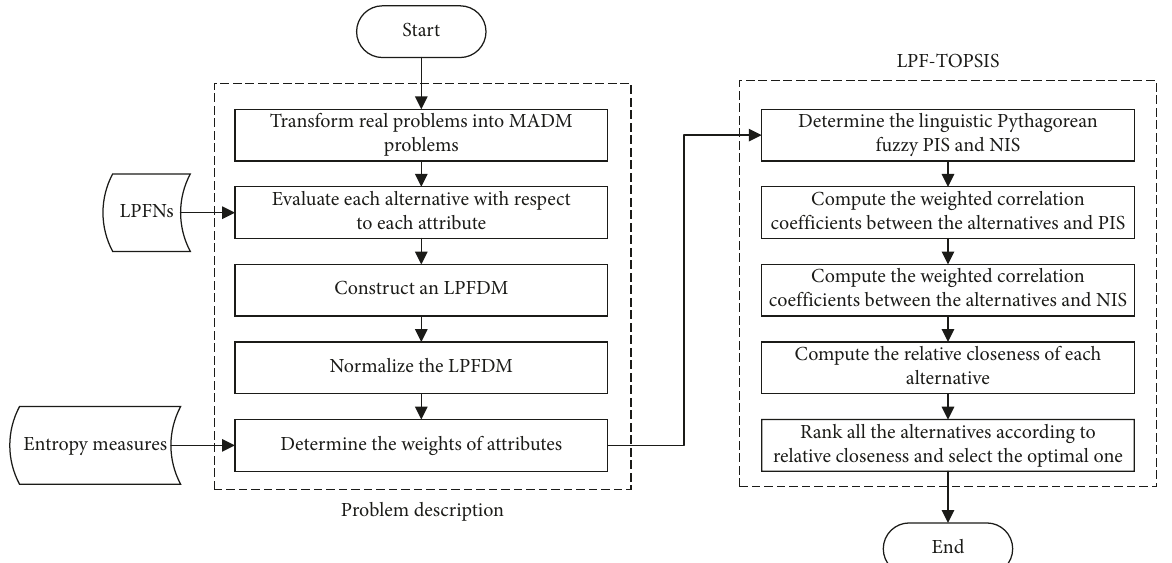
Figure 2: The decision-making procedure of the LPF-TOPSIS